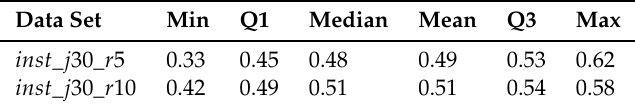
Table 8. X ( I ) value summary for instances of datasets inst _ j 30_ r 5 and inst _ j 30_ r 5, with a 5 min time limit.